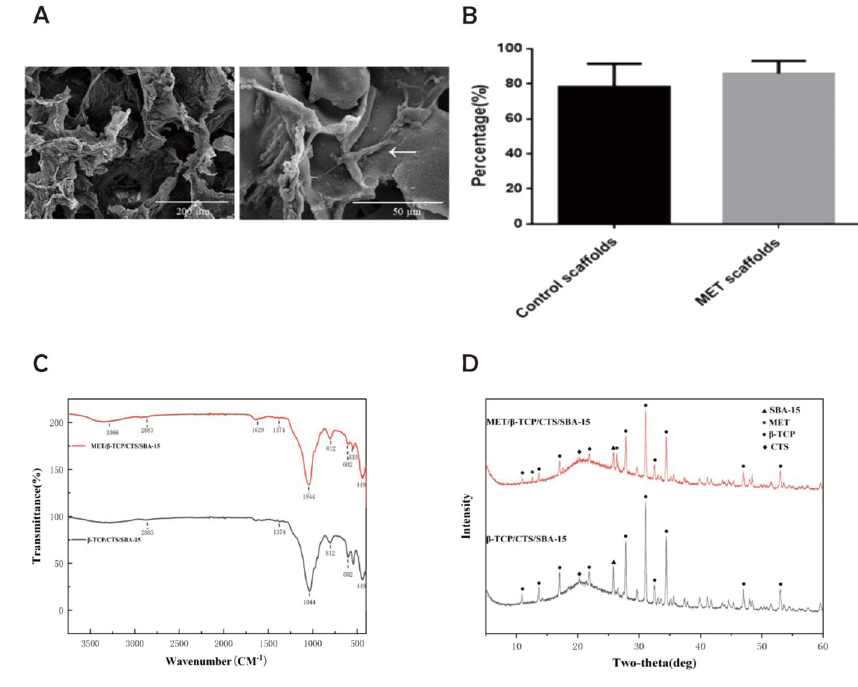
Fig. 3 A Morphology of the third generation rat BMSCs. B The scaffolds in the β -TCP/CTS/ SBA-15 group and the MET/ β -TCP/CTS/SBA-15 group were cultured for 14 days after inoculation with rat BMSCs, stained with alizarin red. The arrow indicated the mineral nodules. C Incubate rat BMSCs with ordinary osteogenic induction medium, scaffold extract of β -TCP/CTS/SBA-15 group plus osteogenic medium, and MET/ β -TCP/CTS/SBA-15 group scaffold extract plus osteogenic medium. Then stain BMSCs with alizarin red